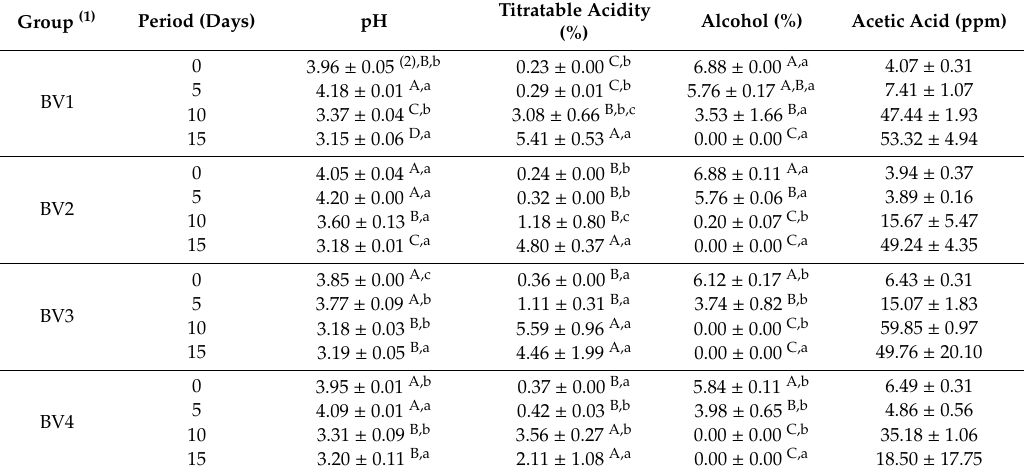
Table 1. Changes in pH, titratable acidity (%), alcohol (%), and content of acetic acid in vinegar produced from fermented bellflower roots. (1) BV1, vinegar from unpeeled bellflower root; BV2, vinegar from peeled bellflower root; BV3, vinegar from unpeeled bellflower root using Acetobacter pasteurianus A11-2; BV4, vinegar from peeled bellflower root using Acetobacter pasteurianus A11-2. (2) Results